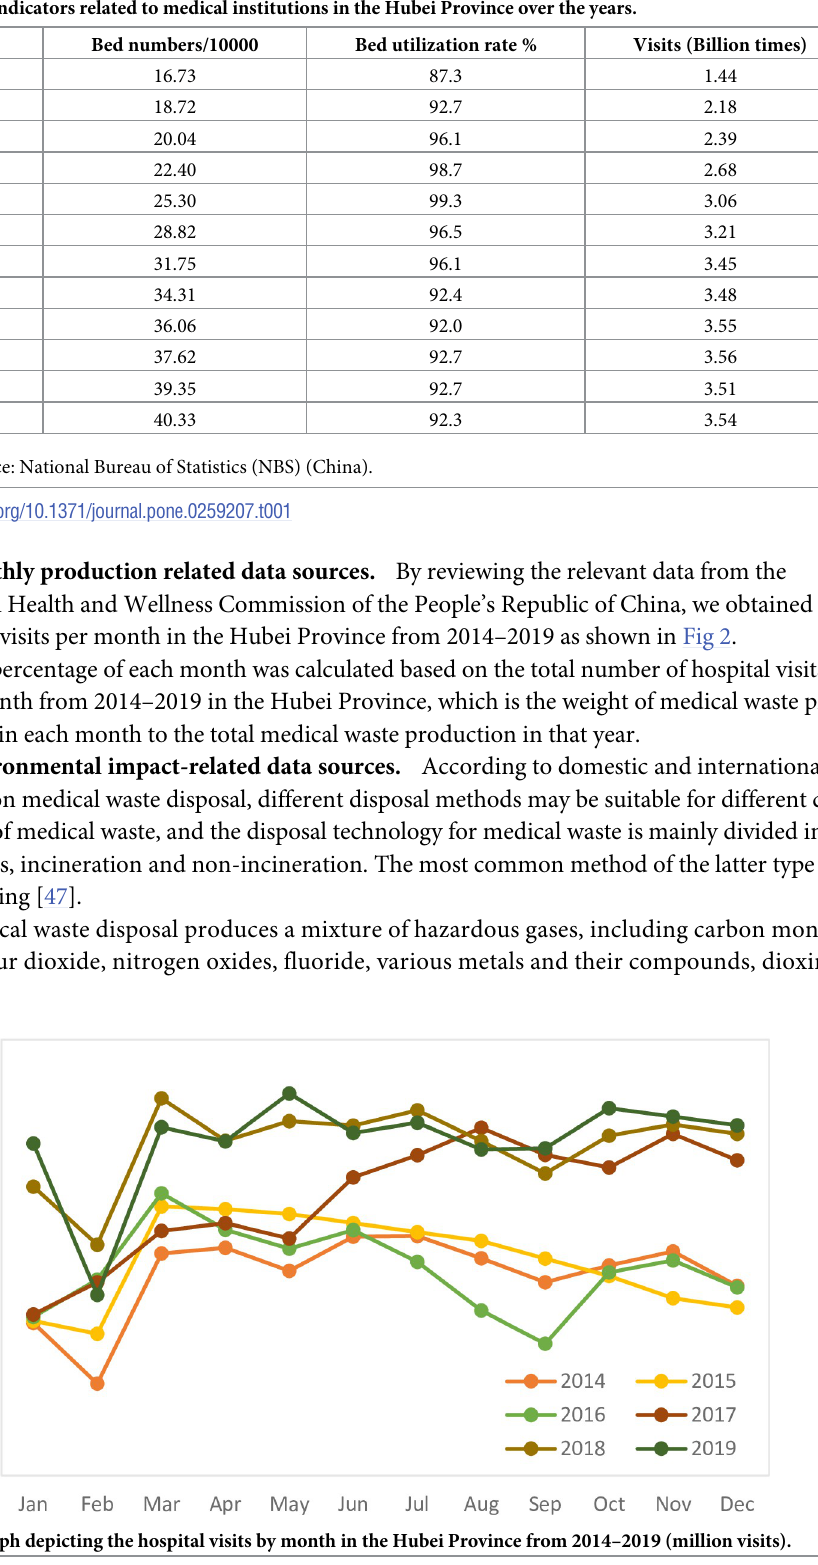
Table 1. Indicators related to medical institutions in the Hubei Province over the years.